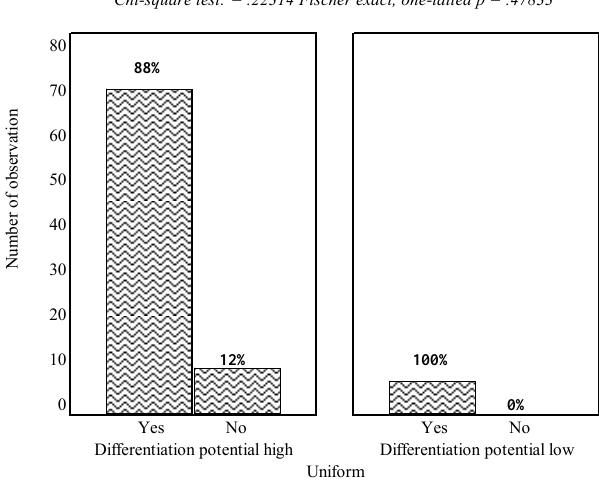
Figure 6: Product characteristic high potential for differentiation/low potential for differentiation and uniform/non-uniform brand transmutation